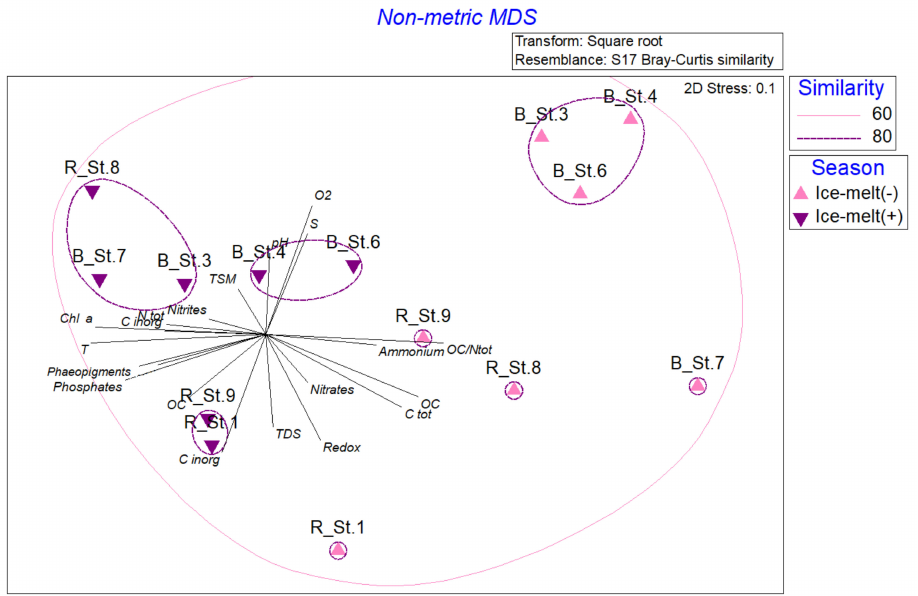
Figure 8. nMDS computed on the relative abundance of phyla detected in both Ice-melt ( − ) and Ice-melt (+) in the Pasvik River at each sampling